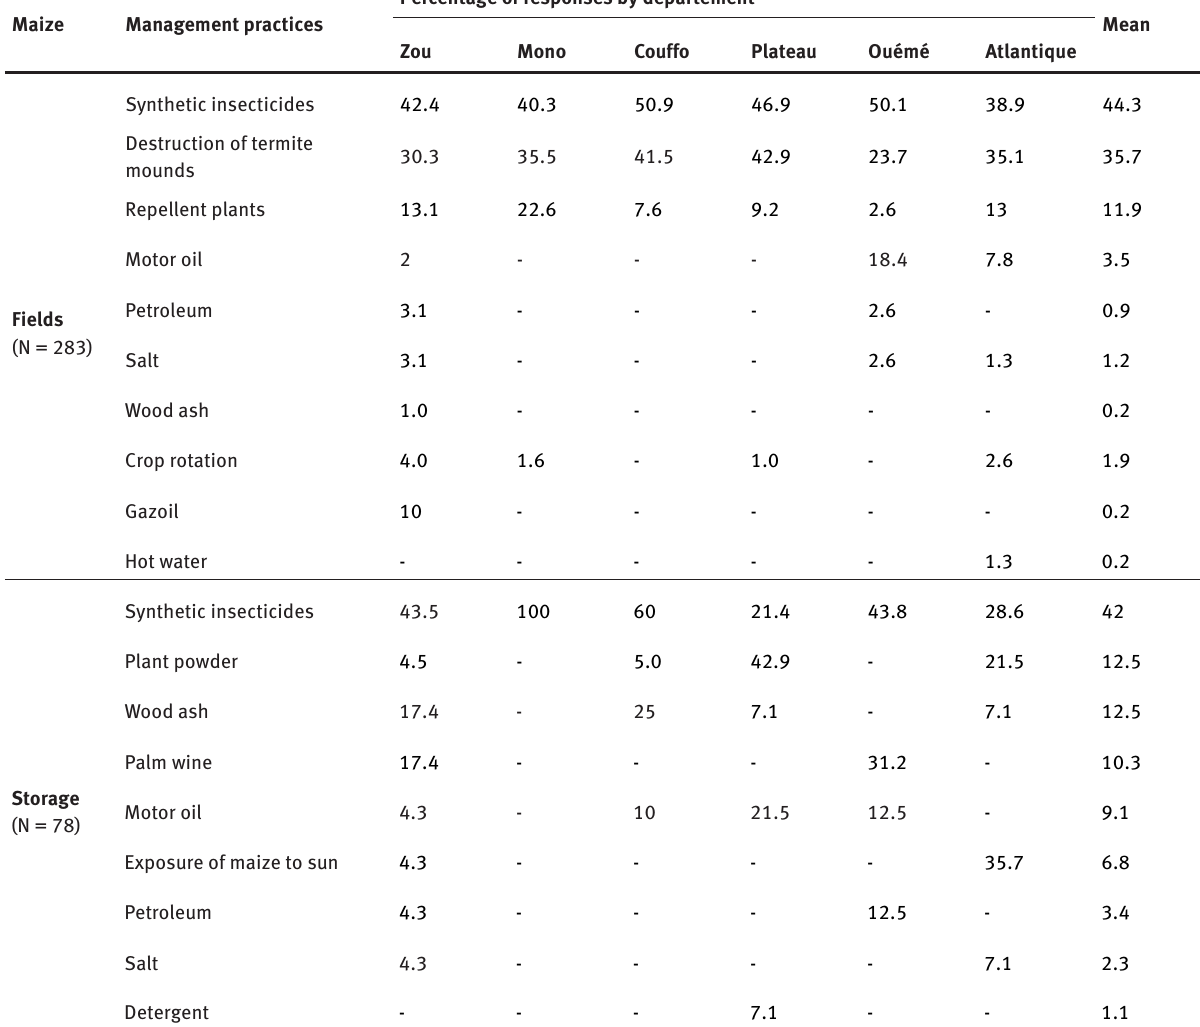
Maize Management practices